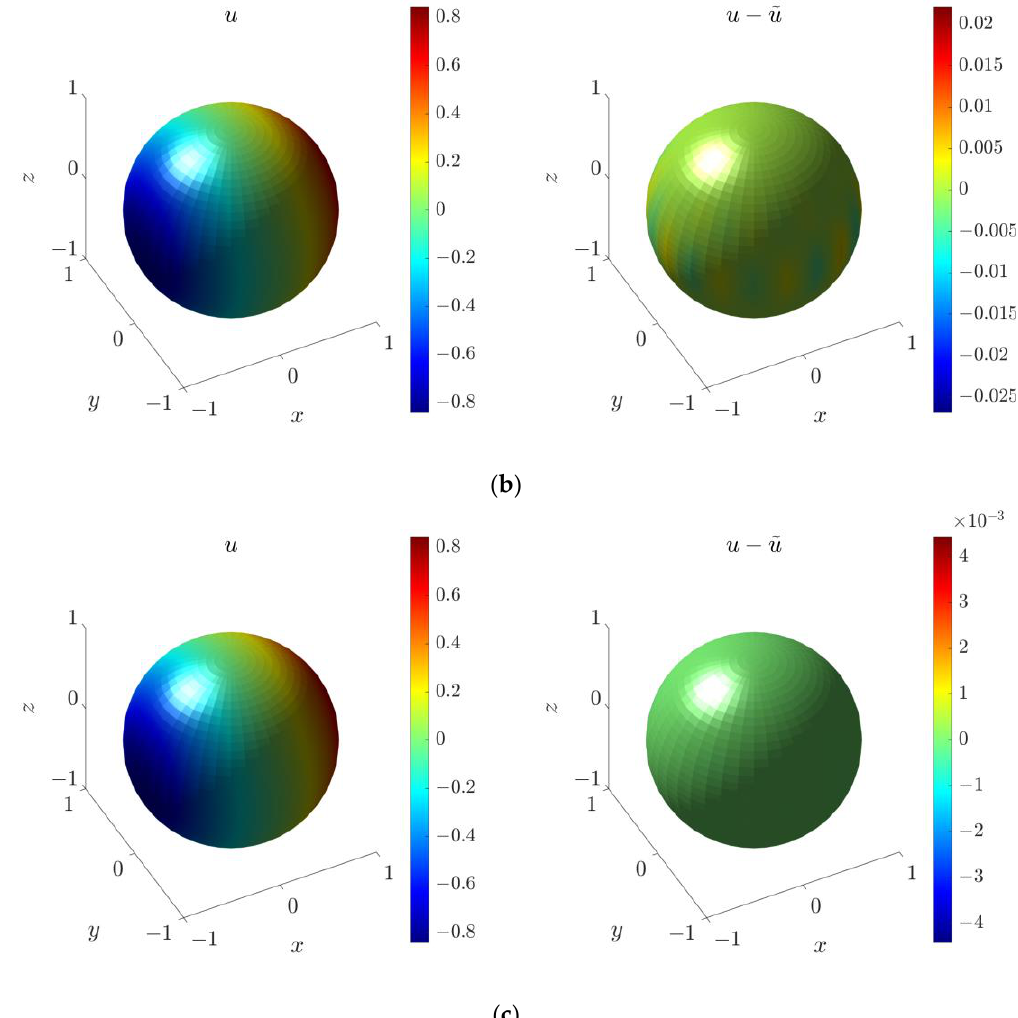
Figure 28. Boundary solution for the 3D parameter identification problem in spherical domain under different discretizations: ( a ) N s = 7 × 7 × 7; ( b ) N s = 9 × 9 × 9; ( c ) N s = 11 × 11 × 11.